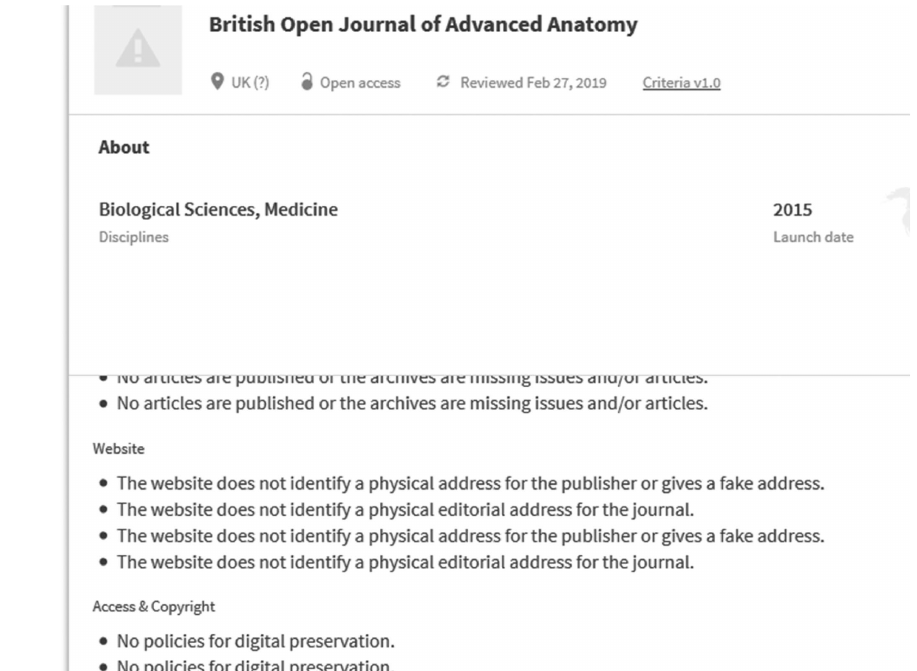
Fig. 4: An example of a journal’s detailed entry in Cabell’s blacklist with identical violations recorded multiple times. Screenshot captured on September 8th,